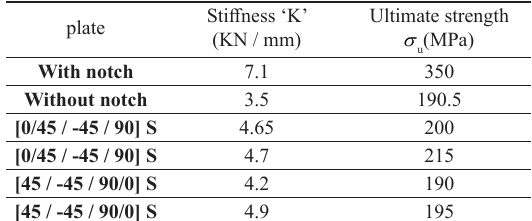
Table 1. Comparison of stiffness and ultimate strength at failure of repaired